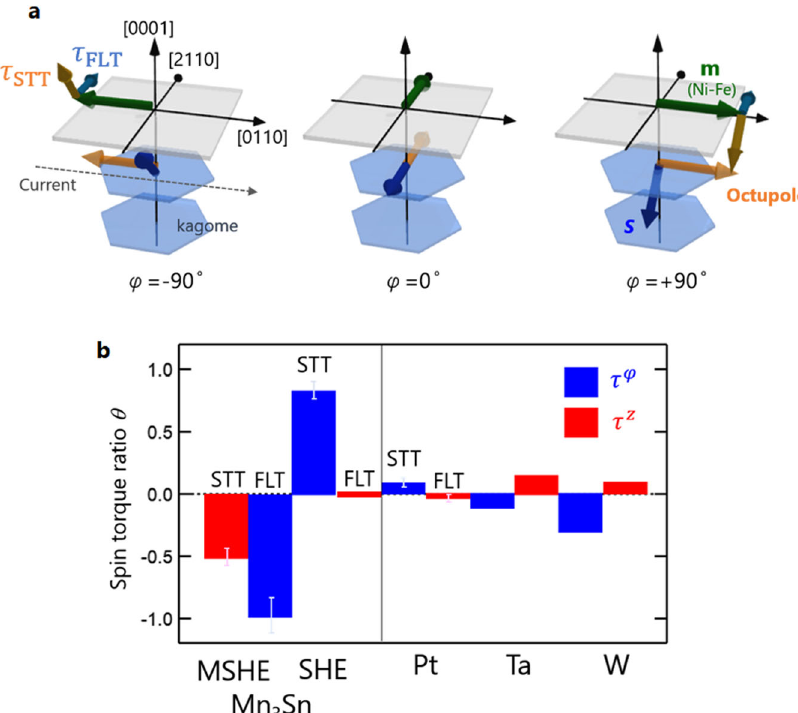
Fig. 5 Giant fi eld-like torque and spin polarization vector of spin accumulation in Mn 3 Sn/Ni-Fe bilayer. a Schematic images of spin polarization vector S (blue arrow) of spin accumulation at Mn 3 Sn/Ni-Fe interface and spin transfer torque (STT) and fi eld-like torque (FLT) as a function of the in-plane direction φ of the magnetization m (green arrow) in Ni-Fe layer. b Comparisons of spin torque ratio θ in Mn 3 Sn and that in typical transition metals. Blue and red bars correspond to τ φ and τ z at φ = 90°. The sign of spin torque due to MSHE is changed for φ = − 90°.